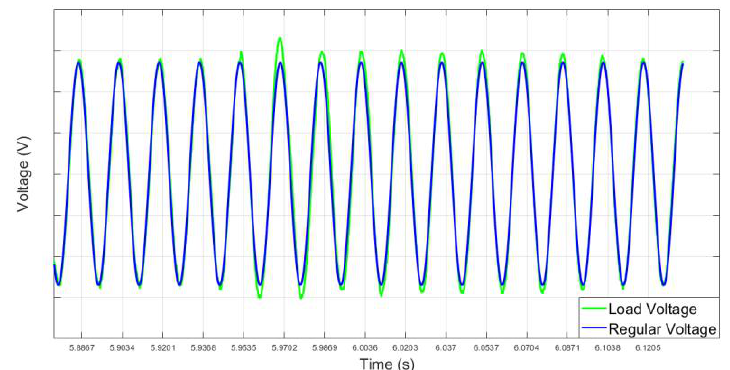
Figure 12. Stage 3: Backup on inductive loads — load voltage of analysis.